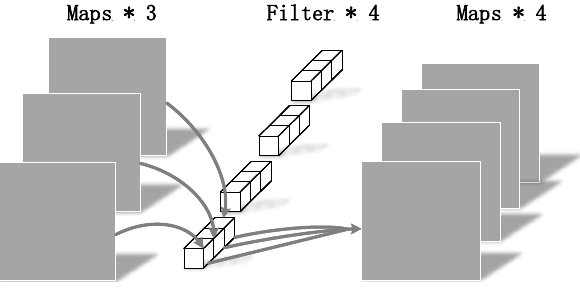
Figure 5. Depthwise convolution.